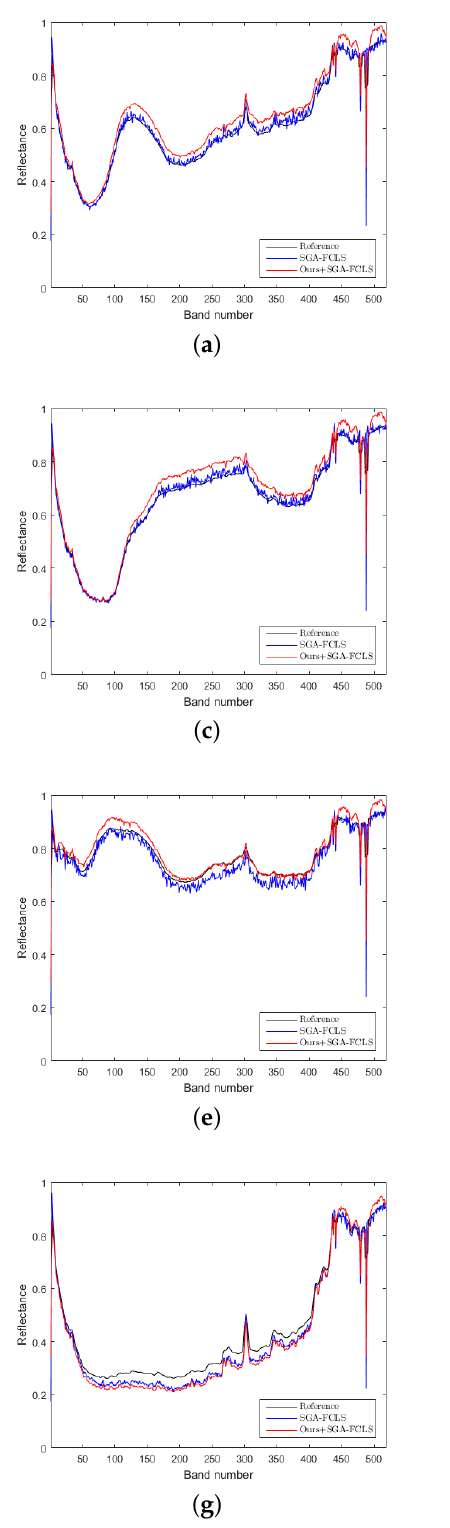
Figure 12. The endmember signatures estimated by different algorithms with/without our method with comparison to reference spectra. ( a ) End. A. ( b ) End. B. ( c ) End. C. ( d ) End. D. ( e ) End. E. ( f ) End. F. ( g ) End.